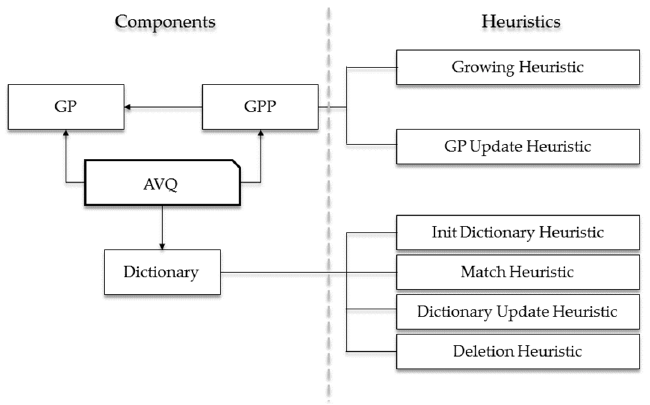
Figure 2. The block diagram of the architecture of the AVQ algorithm.